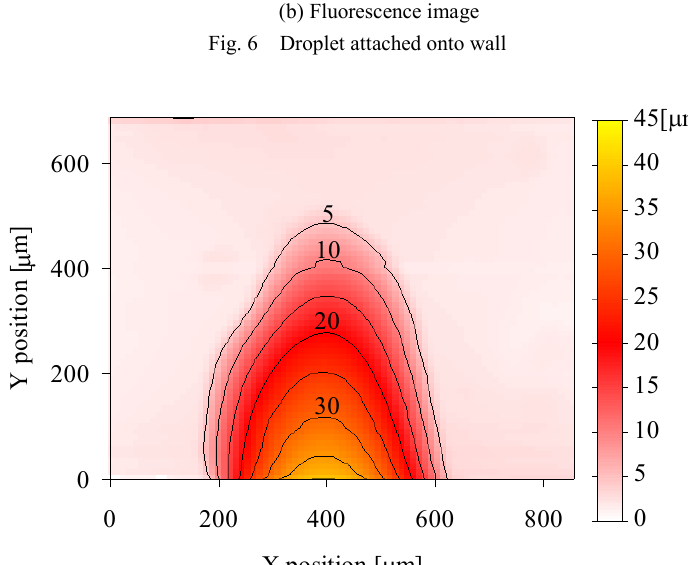
Fig. 6 Droplet attached onto wall